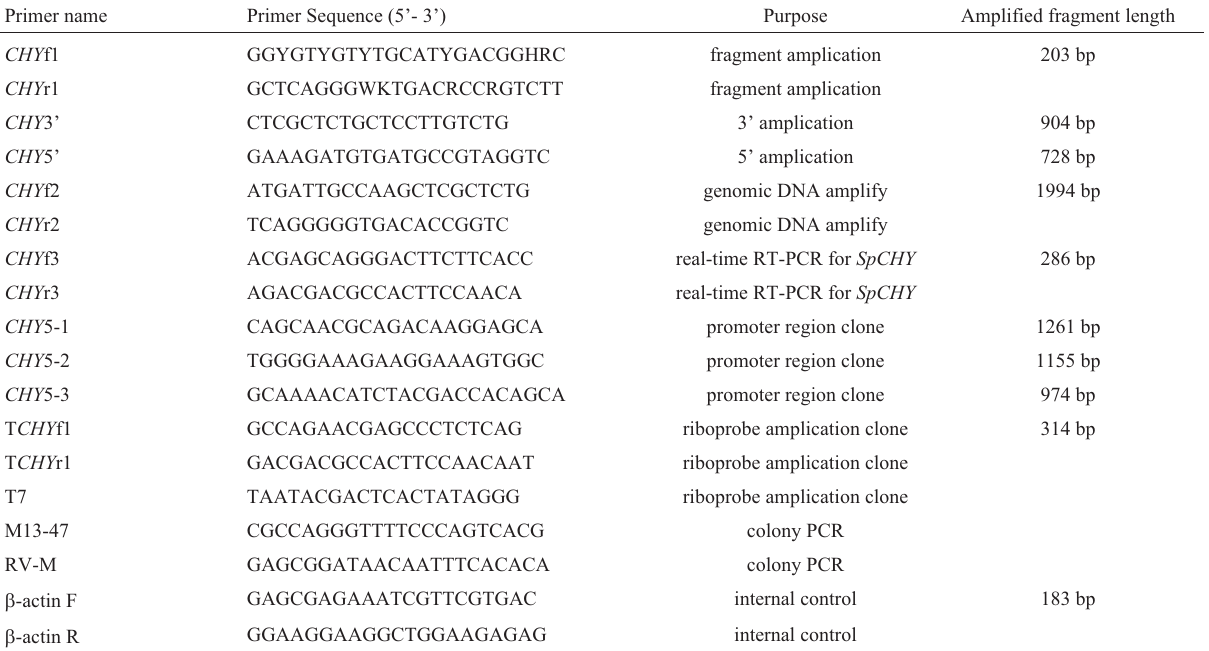
Table 1 - Summary of primers used in this